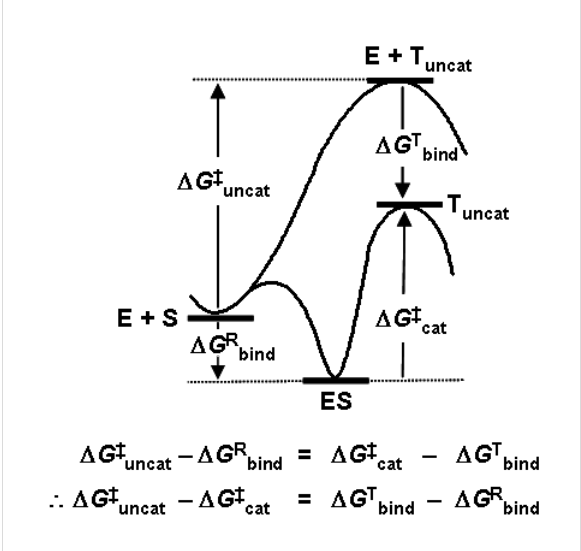
Figure 1: Free energy profiles for reactions of substrate S uncata- lysed and catalysed by enzyme E, showing how the barrier height reduction is equal to the binding energy for transition state T offset by the binding energy for the reactant state